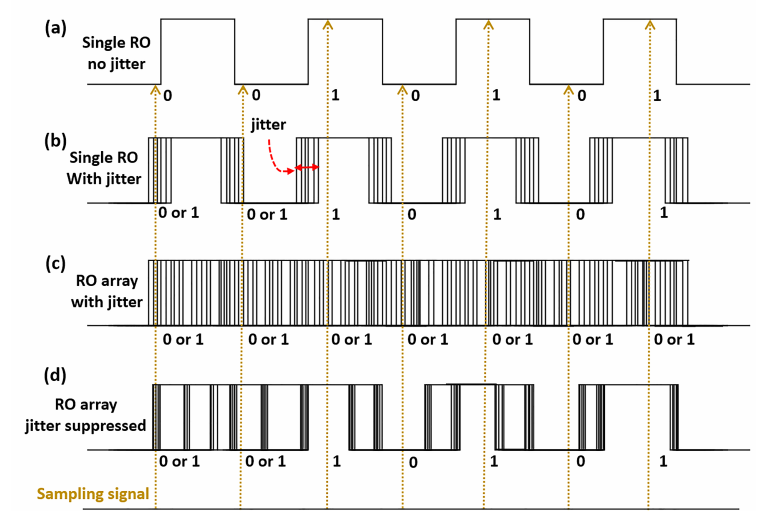
Figure 8. Sampling of the RO oscillating signal. ( a ) Single RO without jitter; ( b ) single RO with jitter; ( c ) RO array with jitter; ( d ) RO array when jitter was suppressed by EMI.